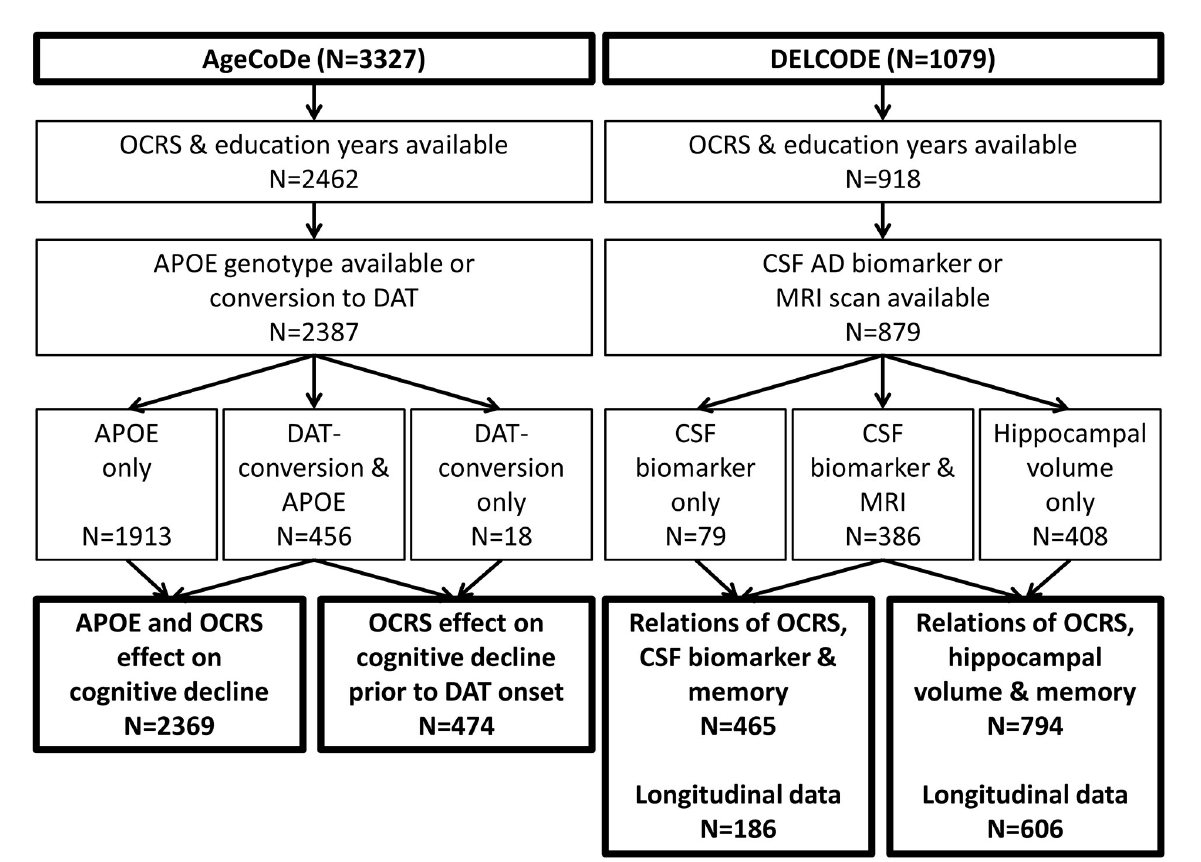
FIGURE2 Flowchart of sample selection. APOE, apolipoprotein E; CSF, cerebrospinal fluid; DAT, dementia of the Alzheimer’s type; OCRS, occupational cognitive requirement